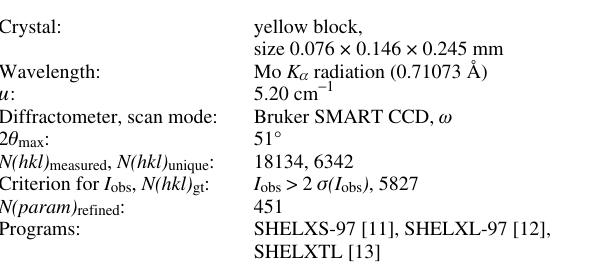
Table 1. Data collection and